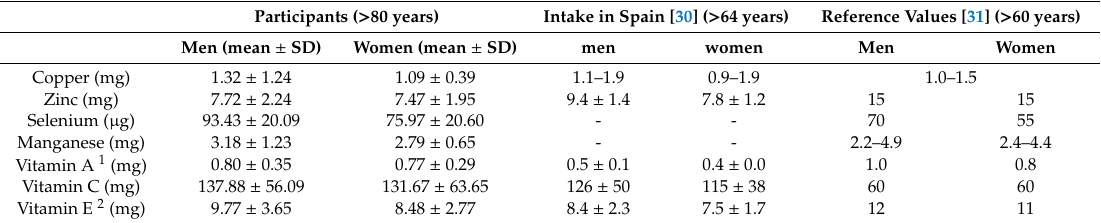
Table 3. Intake of antioxidant nutrients in the free-living elderly population over 80.